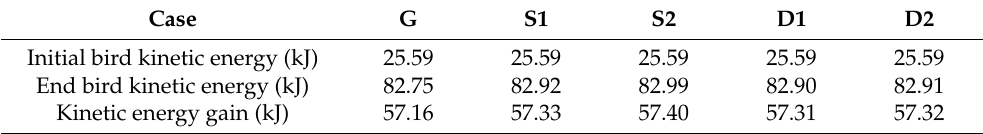
Table 8. The change in the kinetic energy at different support stiffness and